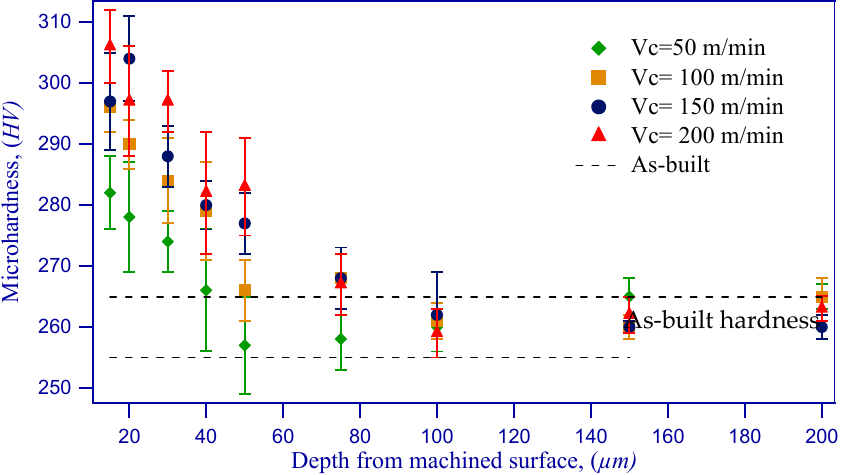
Figure 13. Microhardness of finish-machined and as-built SLMed 316L stainless steel as a function of cutting speed ( f = 0.08 mm/rev).